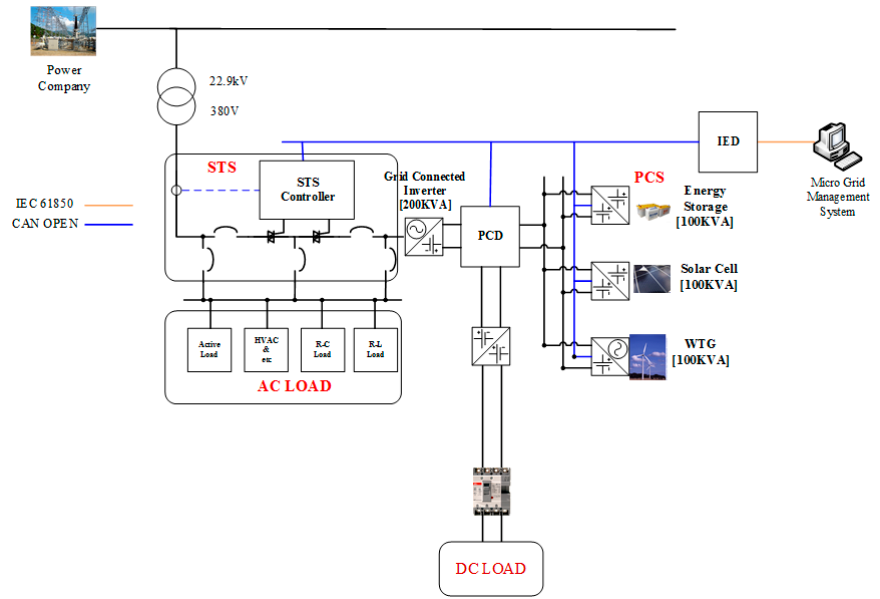
Figure 2. System composition of the AC/DC switchgear panel.